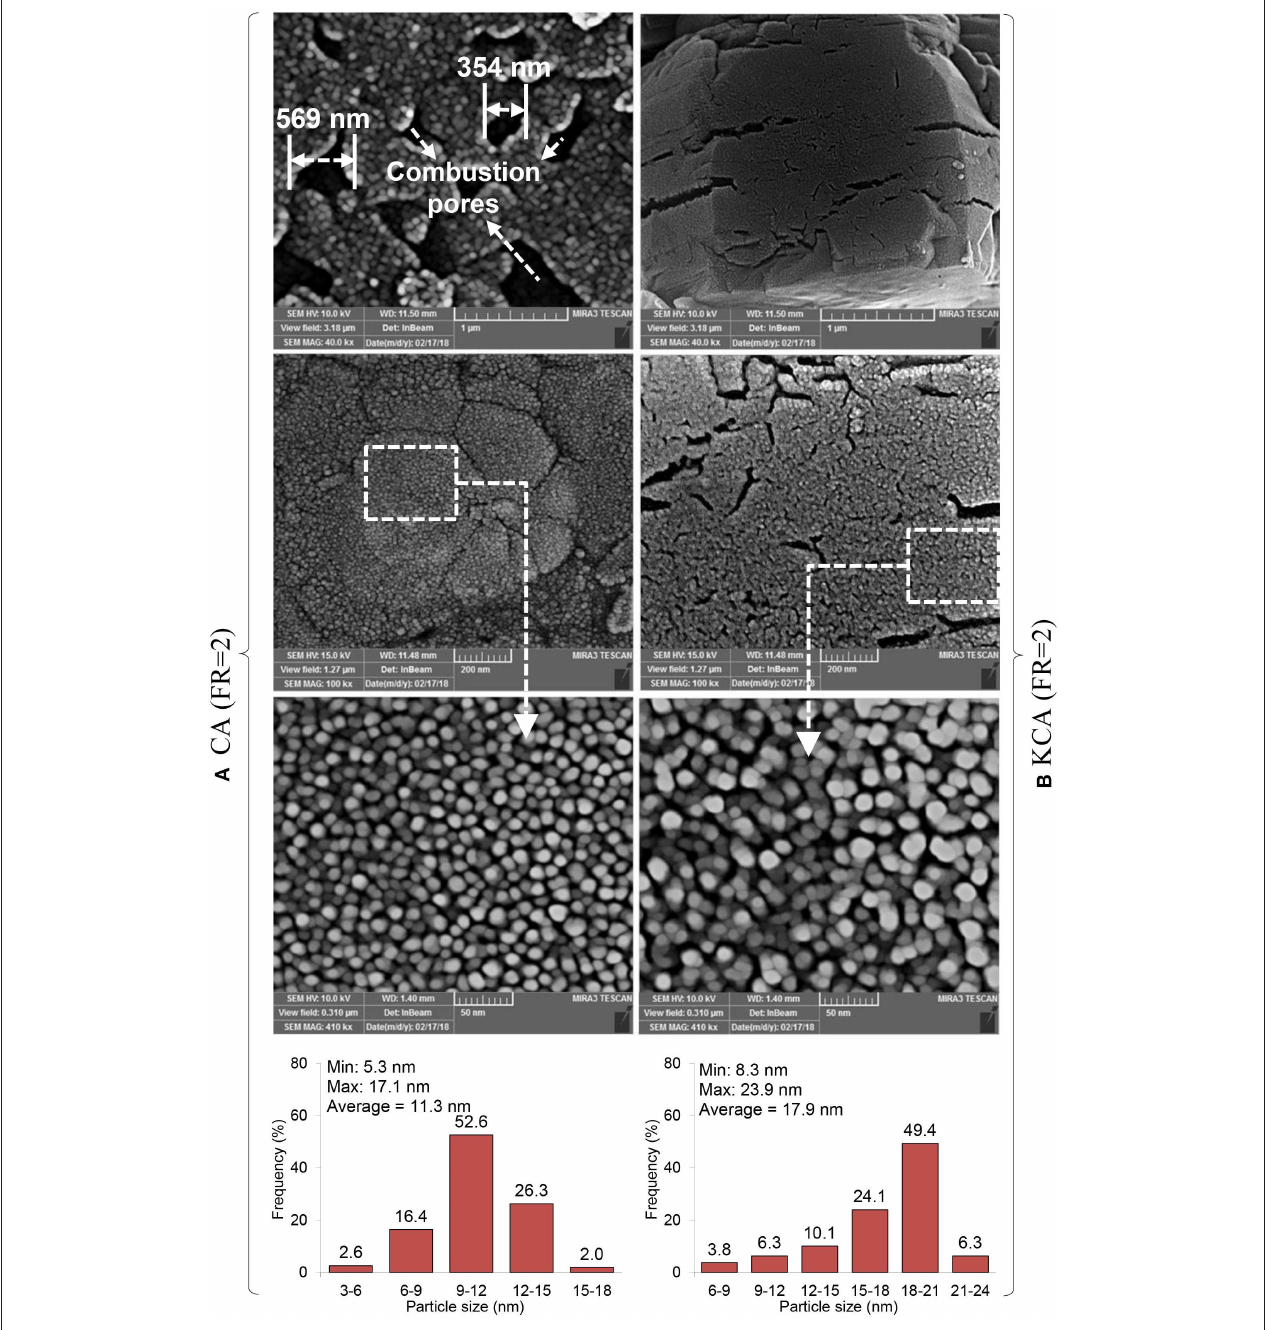
FIGURE 7 | FESEM images of synthesized CaAl 2 O 4 support and KOH/Ca 12 Al 14 O 33 nanostructured catalyst: (A) CA(FR = 2) and (B) KCA(FR = 2).